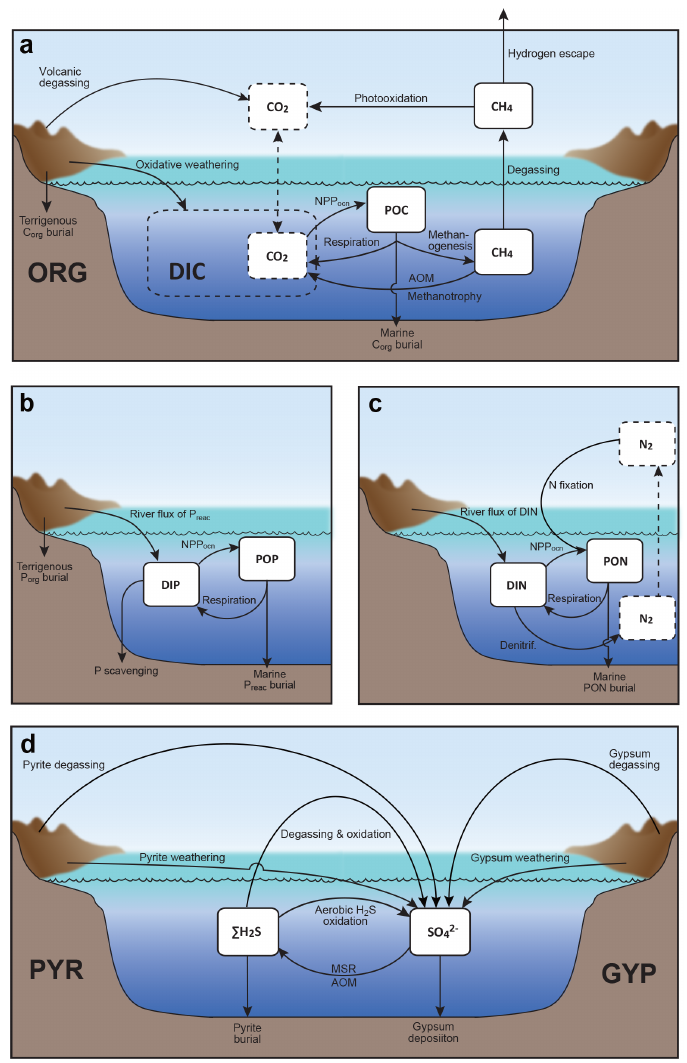
Figure 2. Schematics of global biogeochemical cycling in CANOPS-GRB. (a) Global C cycle. The primary source of C for the ocean– atmosphere system is volcanic degassing and oxidative weathering of sedimentary organic carbon, whereas primary sink is burial of marine and terrigenous organic matter into sediments. Inorganic carbon reservoirs (depicted as dashed boxes) and DOC are not considered. NPP ocn represents marine net primary production. DIC stands for dissolved inorganic carbon. POC stands for particulate organic carbon. MSR stands for microbial sulfate reduction. AOM stands for anaerobic oxidation of methane. CANOPS-GRB includes CH 4 generation via methanogen- esis and its oxidation reactions via methanotrophy and AOM in the ocean interior, as well as CH 4 degassing flux to the atmosphere and its photooxidation. The rates of CH 4 photooxidation and hydrogen escape to space are calculated based on parameterizations proposed by previous studies (Goldblatt et al., 2006; Claire et al., 2006). Note that CH 4 flux from land biosphere is not shown here. (b) Global P cycle schematic. Weathering of reactive P (P reac ) is the ultimate source, whereas burial in sediments is the primary sink. A part of the weathered P is buried as terrigenous organic P, and the remaining amount is delivered to the ocean. The redox-dependent P burial in marine sediments is modeled by considering three phases (organic P, Fe-bound P, and authigenic P). DIP stands for dissolved inorganic phosphorus. POP stands for particulate organic phosphorus. The hypothetical P scavenging via Fe species in anoxic-ferruginous waters is depicted, but it is not modeled in our standard model configuration. (c) Global N cycle schematic. The abundance of inorganic nitrogen species (ammonium and nitrate), which are lumped into DIN (dissolved inorganic nitrogen), is affected by denitrification and nitrification. The primary source is nitrogen fixation and riverine flux, whereas primary sink is denitrification and burial in marine sediments. PON stands for particulate organic nitrogen. The nitrogen weathering and riverine flux is assumed to be equal to the burial flux so that there is no mass imbalance in global N budget. Aeolian delivery of N from continent to the ocean is not included. (d) Global S cycle schematic. The reservoir sizes of sedimentary sulfur (pyrite sulfur, PYR, and gypsum sulfur, GYP) and two sulfur species (SO 2 − and (cid:54) H 2 S) in the ocean are controlled by volcanic 4 outgassing, weathering, burial, MSR, AOM, and sulfide oxidation reactions. Weathering and volcanic inputs are the primary source of S to the ocean, and burial of pyrite and gypsum in marine sediments is the primary sink. It is assumed that hydrogen sulfide escaping from the ocean to the atmosphere is completely oxidized and returns to the ocean as sulfate. The organic sulfur cycle is ignored in this